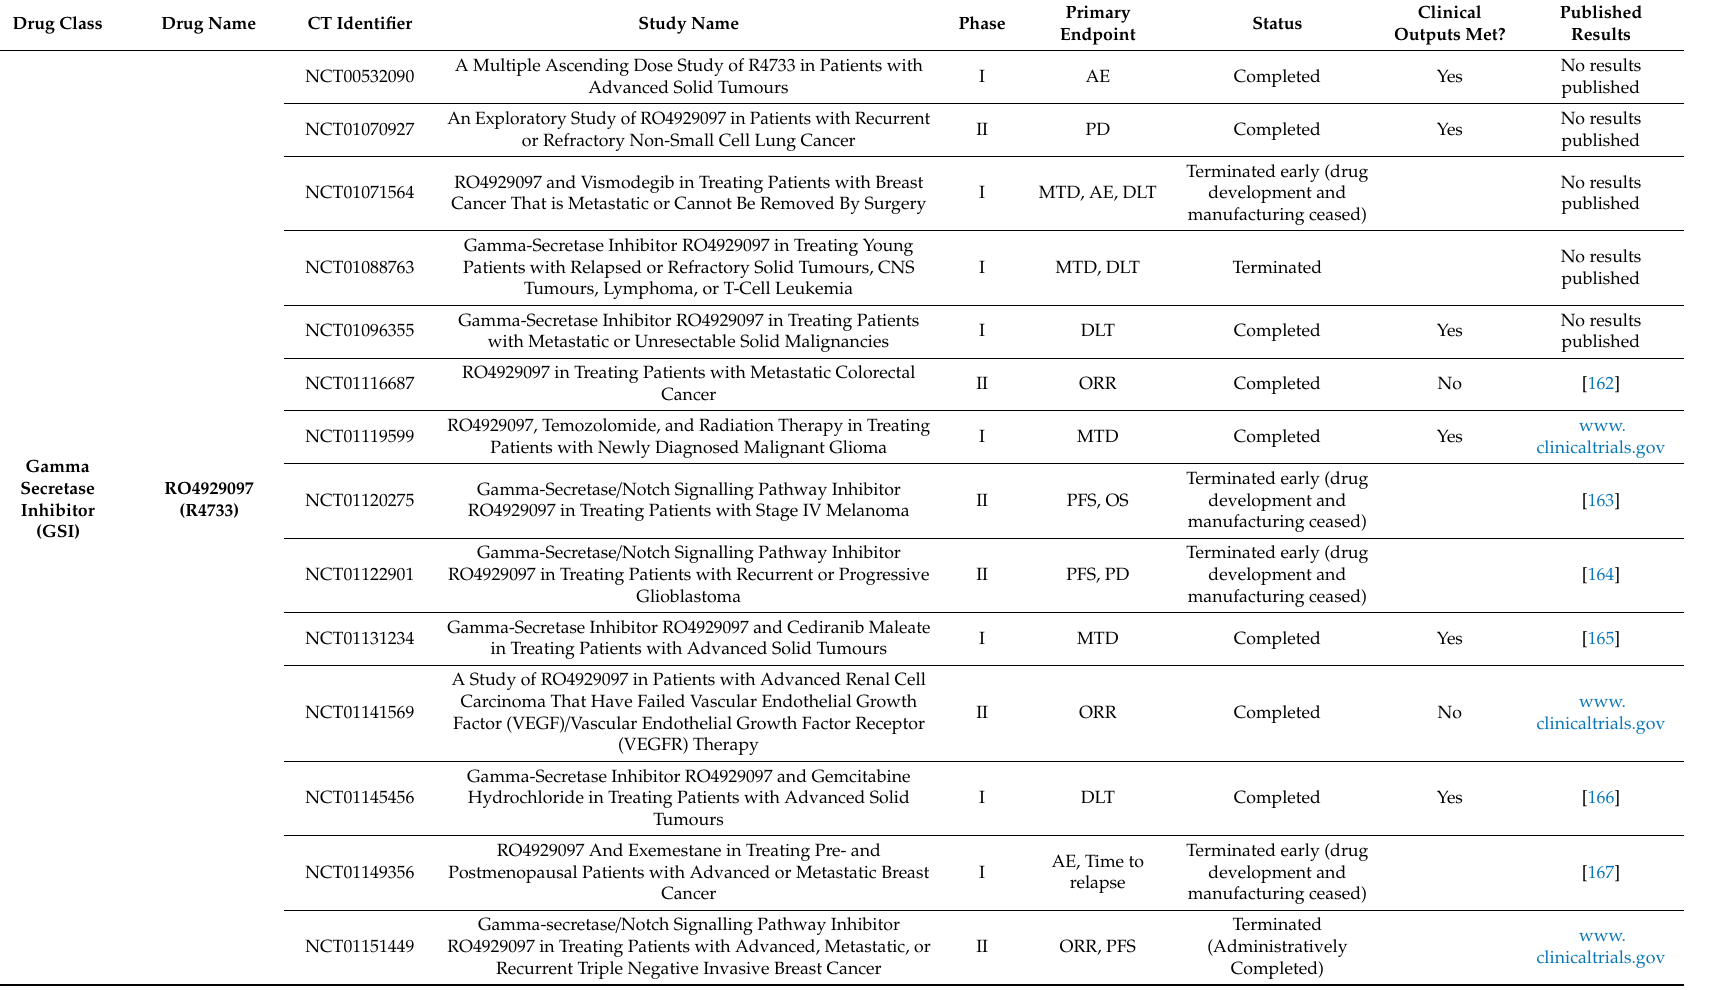
Table 1. A current summary of cancer clinical trials involving Notch